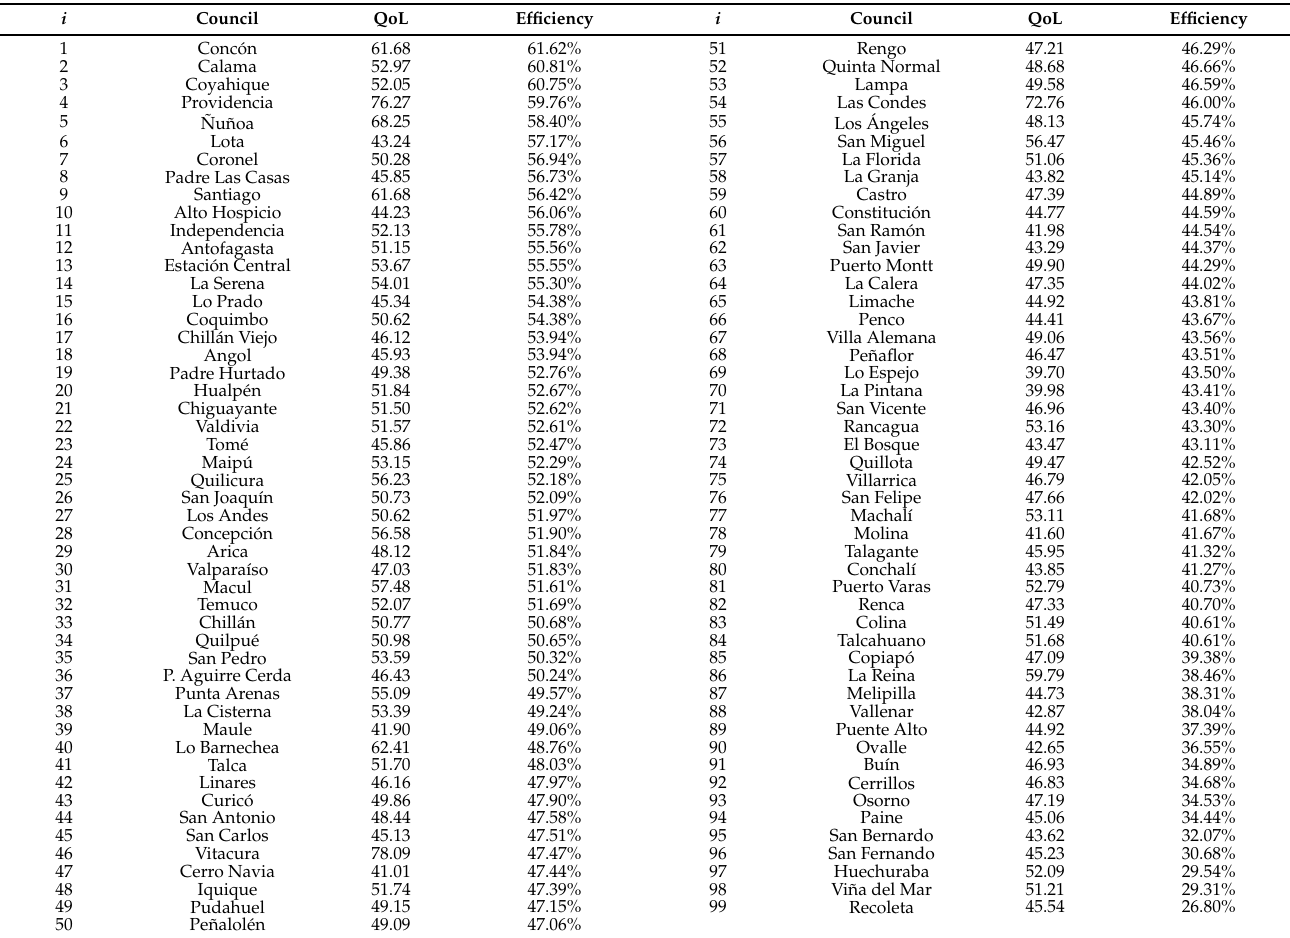
Table 12. Efficiency and quality of life per council ranked from highest to lowest